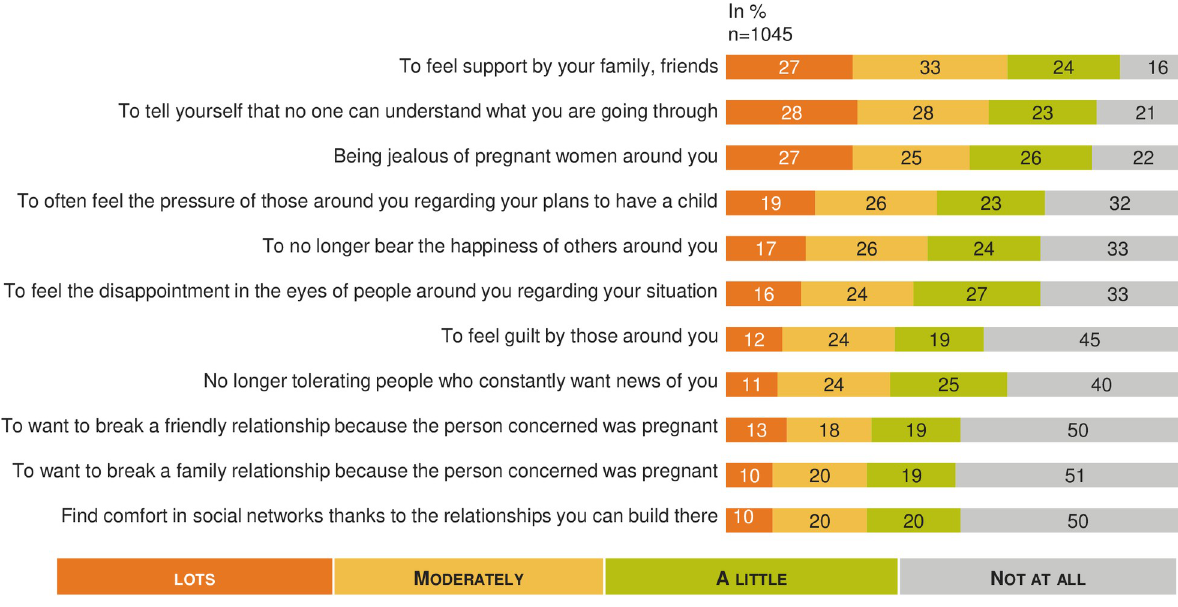
PLOS ONE | https://doi.org/10.1371/journal.pone.0238945 September 24,